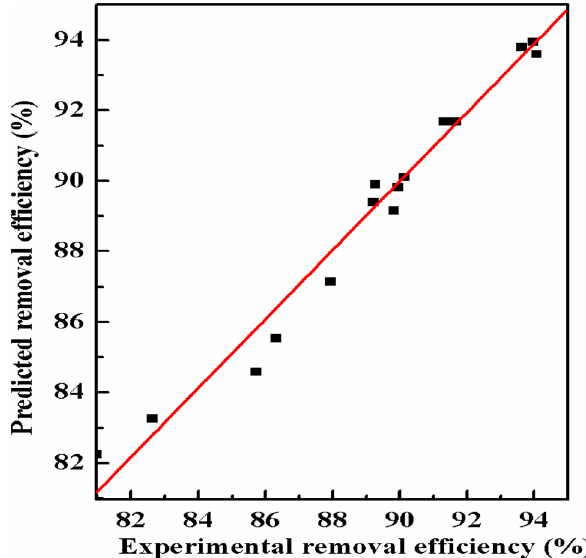
Fig. 6 The actual and predicted plot of CO 2 removal efficiency (%)